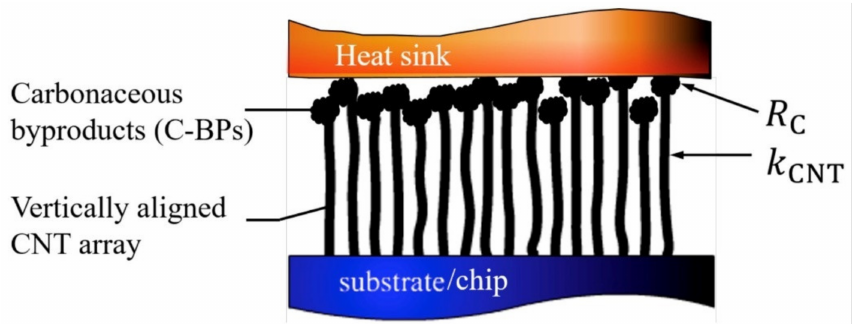
Figure 3. Construction of a thermal interface material (TIM) and the key parameters influencing heat transport [148]; copyright Elsevier